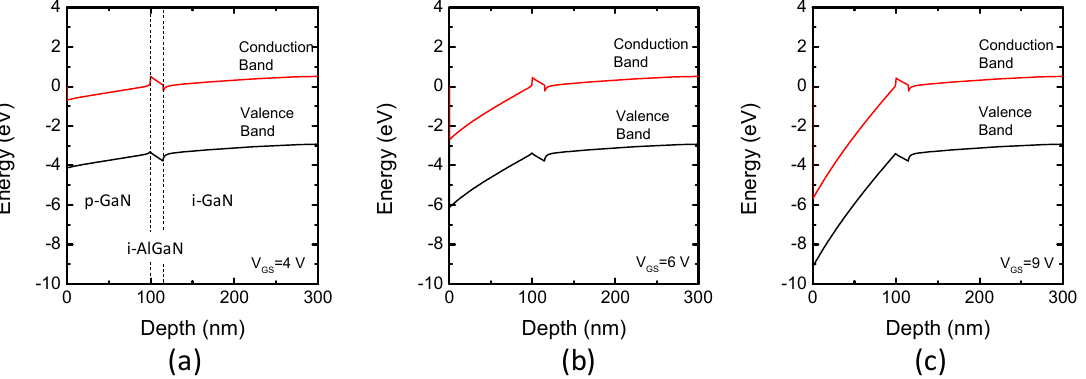
Figure 8. Band diagram of a HEMT with p-GaN gate, as simulated under the gate. The three frames refer to different gate voltages: ( a ) V GS = 4 V; ( b ) V GS = 6 V; ( c ) V GS = 9 V. Courtesy of Eldad Bahat-Treidel, FBH (Berlin, Germany).